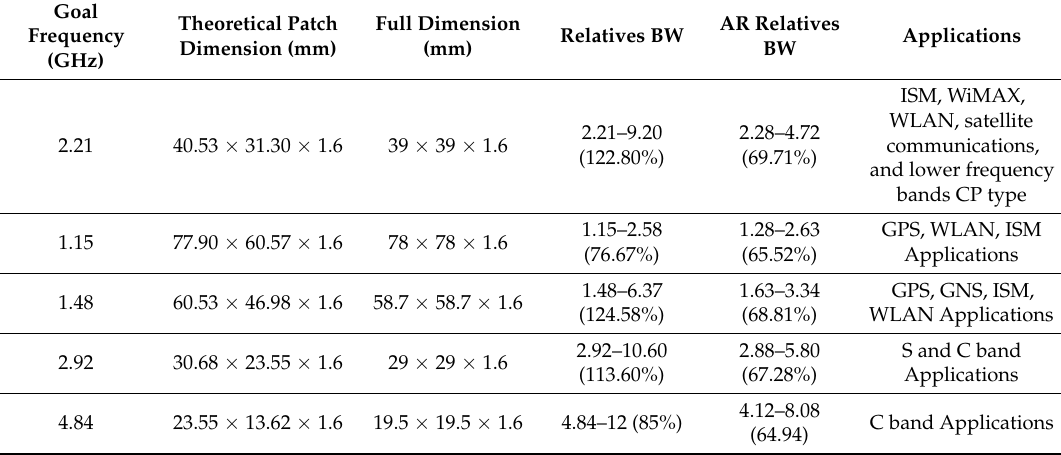
Table 2. Scaling the dimensions with performance and